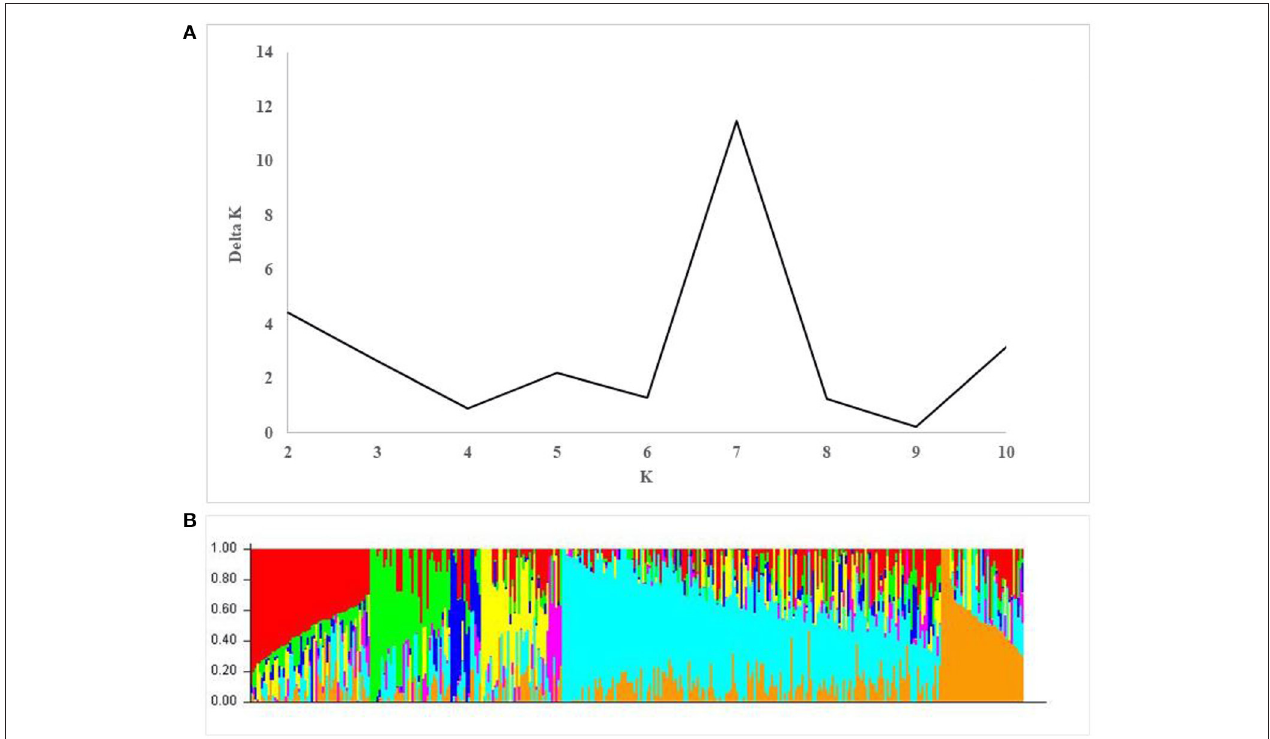
FIGURE 2 | Population structure in the association mapping (AM) panel. (A) Estimation of the number of populations by calculating delta K values. (B) Estimated population structure of the AM panel ( k =